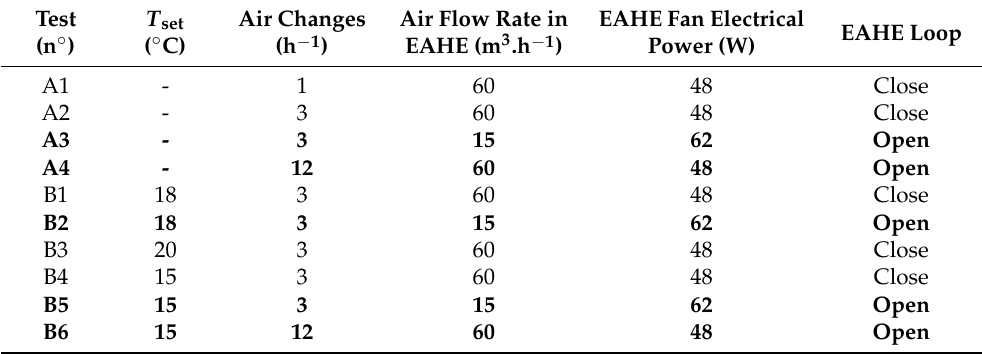
Table 3. Tests table, with 24 h duration for each experience, where tests A considered the heating OFF, and tests B considered the heating